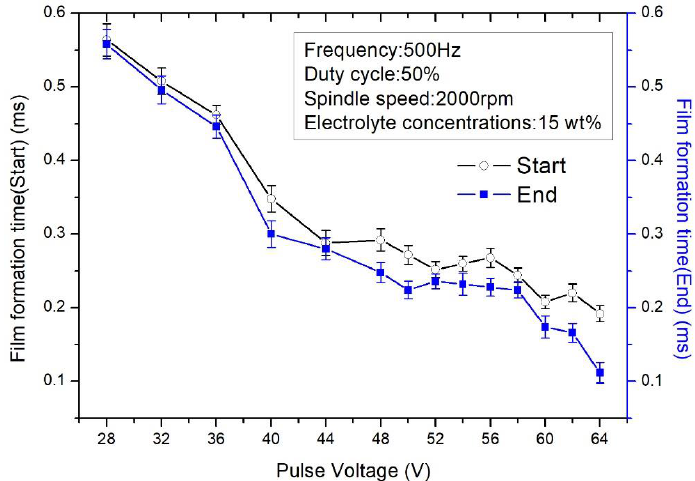
Figure 7. Relationship between the voltage and film formation time before and after